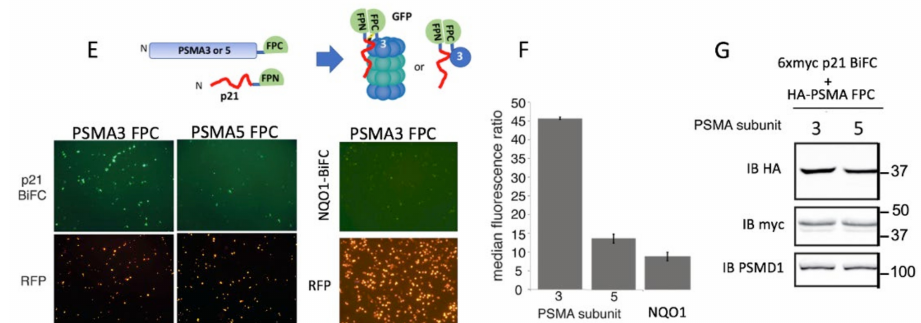
Figure 2. PSMA3 interacts with p21 in the cells. ( A ) U2OS cells stably expressing PSMA3–FPC. Cell lysates were enriched with proteasomes by ultracentrifugation and loaded on native gel. The membrane was probed with antibody against either HA-tag or the endogenous subunit PSMA4. ( B ) Schematic description of the antibodies used against the different 26S proteasome subunits for the described co-immunoprecipitation experiments to demonstrate the possible incorporation of a chimeric PSMA3 subunit into proteasomes. The endogenous PSMA1 subunit was first immunopre- cipitated and the level of the co-immunoprecipitated subunits was monitored using antibodies to detect the endogenous PSMD1, a subunit of the 19S proteasome, and anti-HA to detect the chimeric PSMA3. ( C ) The schematic description of the experimental strategy of serial consecutive immuno- precipitation steps. ( D ) The results obtained from each of the steps described in Panel C. HEK293 cells expressing HA–PSMA3–FPC were harvested 24 h post-transfection. Cells’ lysate was subjected to four subsequent immunoprecipitations of proteasomes via the endogenous PSMA1 subunit. Ten percent of cell lysate was kept for analysis after each immunoprecipitation. ( E ) Cells were transfected with either PSMA3–FPC or PSMA5–FPC together with p21 FPN (see scheme). We also transfected the cells with H2B–RFP, which provides RFP labeling of the transfected cells’ nuclei. Successful BiFC using fluorescent microscopy, 20 × objective 48 h post-transfection. ( F ) Intensities of at least 10,000 cells for each PSMA–p21 and PSMA–NQO1 combination were recorded by flow